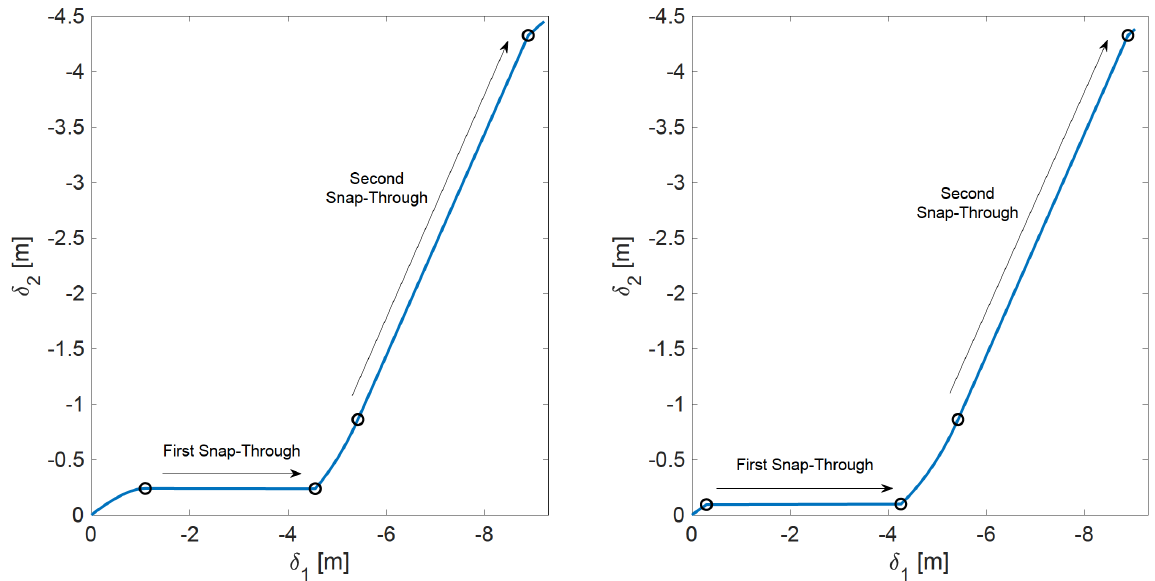
Figure 18: δ 1 vs δ 2 curves for increasing load: Case 1 (left graph) and Case 2 (right